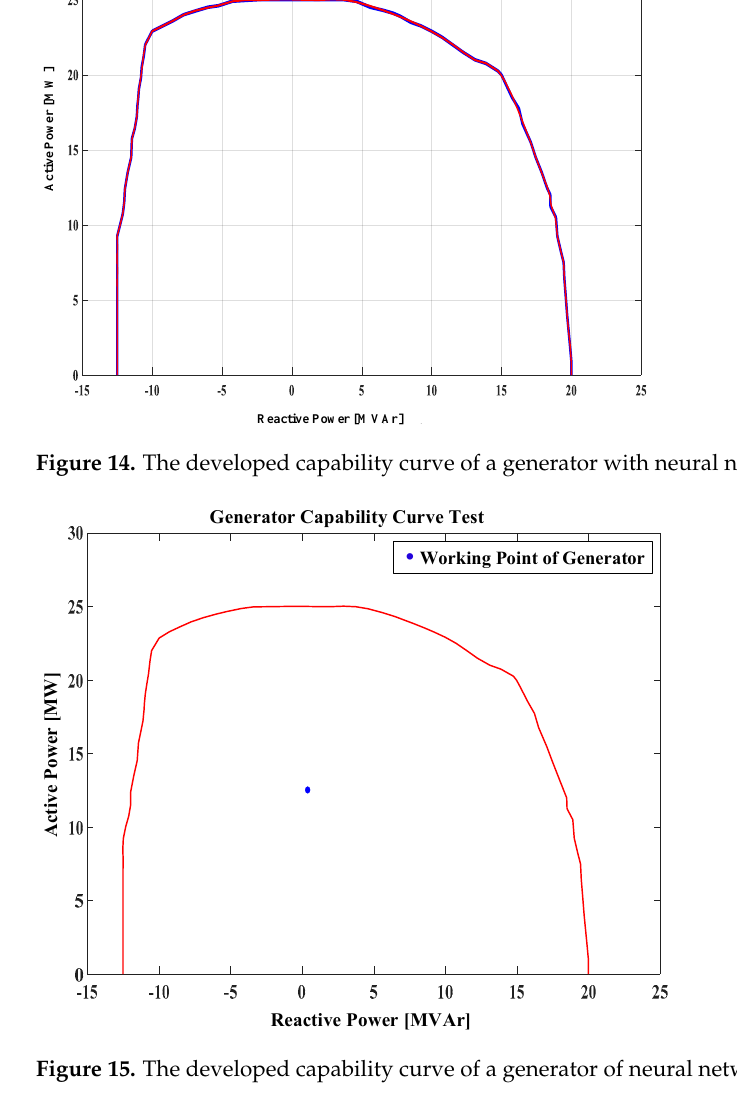
Figure 14. The developed capability curve of a generator with neural network training.